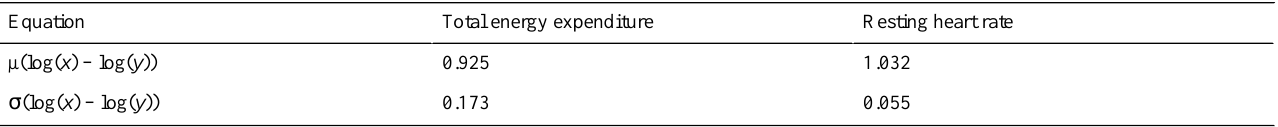
Resting heart rateTotal energy expenditureEquation